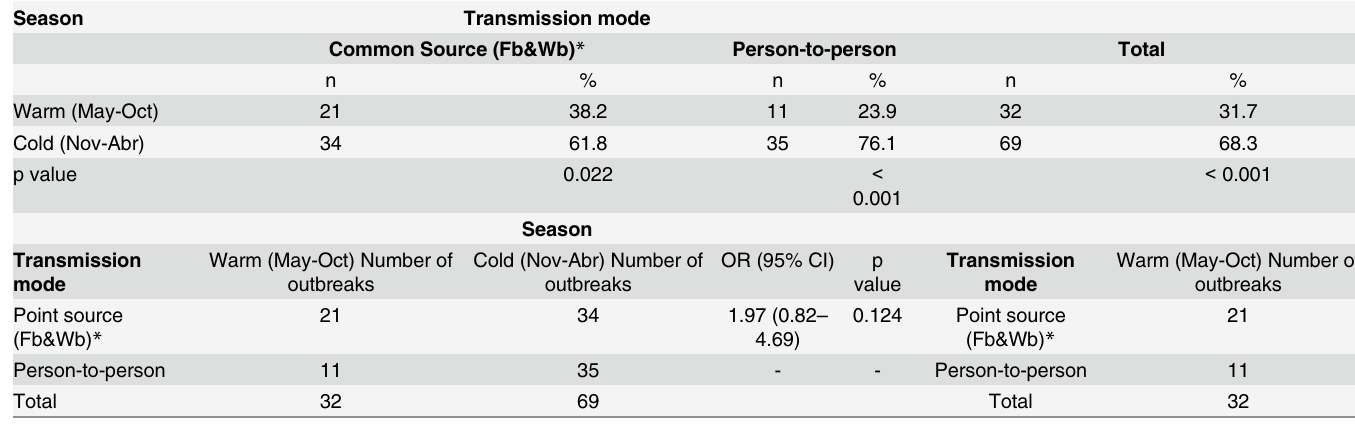
Table 3. Distribution of percentage of outbreaks by season of the year and transmission mode. Catalonia 2010 –